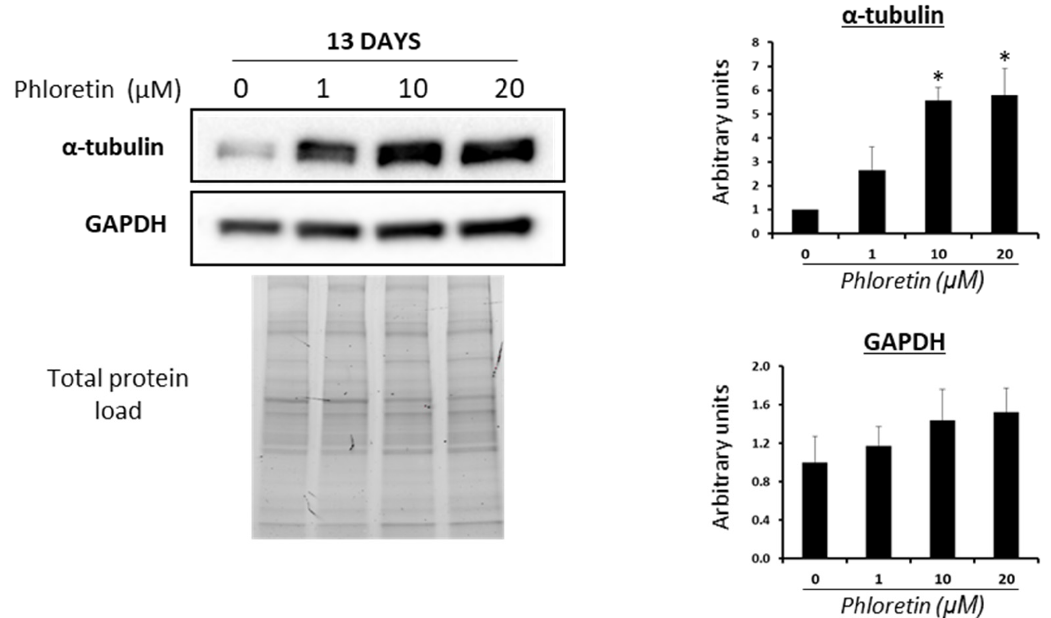
Figure 5. Western blot for α -tubulin and GAPDH of cultures treated with different concentrations of phloretin, at day 13 of adipogenic differentiation. Results of quantification of Western blot bands are shown in the graphs. Protein loading was used for the normalization of values. * p < 0.05 vs. cultures no treated (0 µM of phloretin).